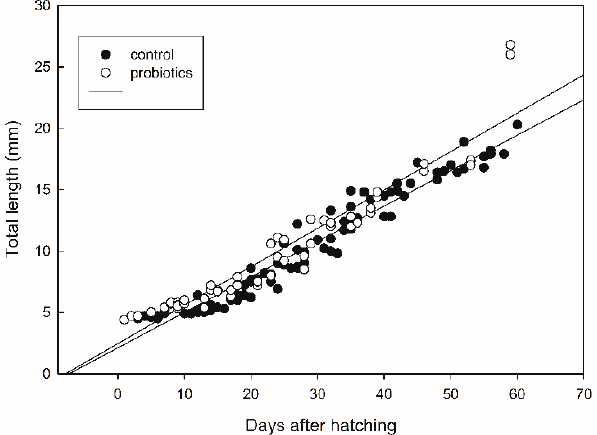
Figure 3. Growth expressed as total fish length (mm) in seabass larvae and juveniles. A regression line was drawn for each treatment. The regression line with the highest slope represents the growth in the probiotic treatment.